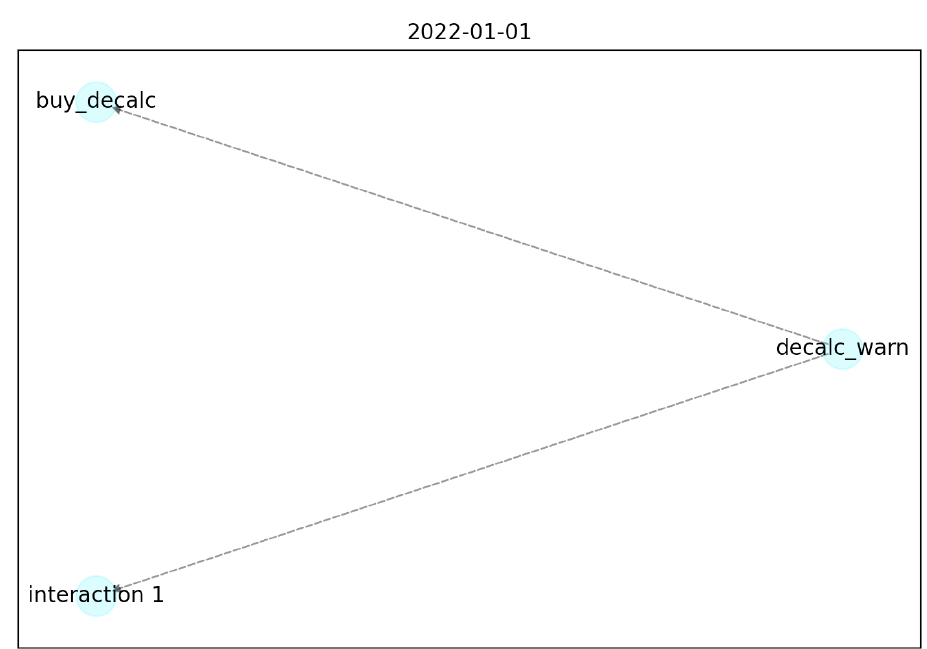
Figure 5. Example: Behavior graph after 1 day. All the edges are dashed and gray, based on the value of the adjacency matrix. After 2 months the graph (Figure 6) remains the same, except for the color of the edges, indicates that the adjacency matrix value is growing, and for adding another noise interaction (interaction_2).